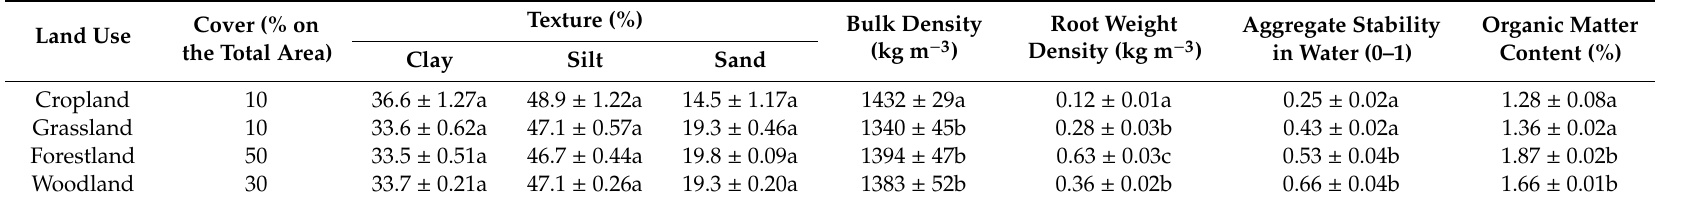
Table 2. Main characteristics of soils under four land uses in the Saravan watershed (Northern Iran).